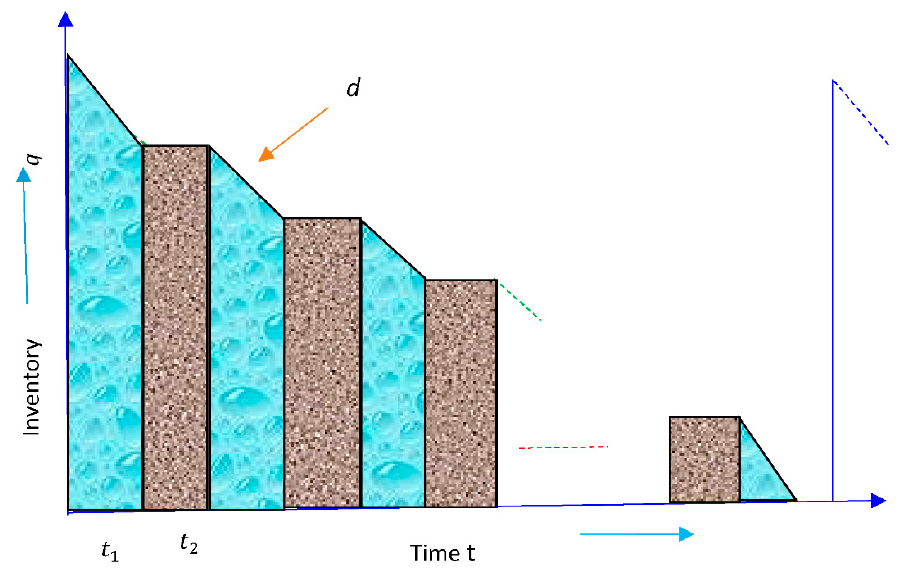
Figure 3. Logistic diagram of inventory system.